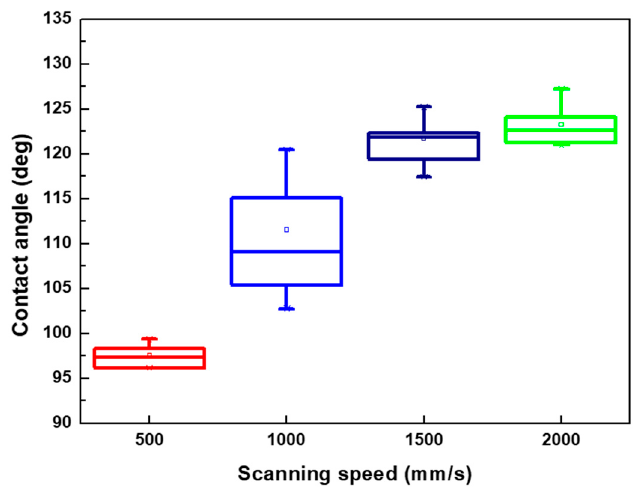
Figure 9. Contact angle of physiological saline droplet on the XO RGP contact lens with line pitch of 30 μ m under four various laser scanning speeds.